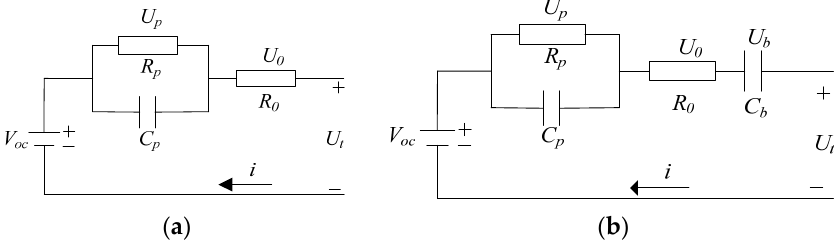
Figure 2. Schematic diagram of equivalent circuit models: ( a ) Thevenin model; ( b ) PNGV model.